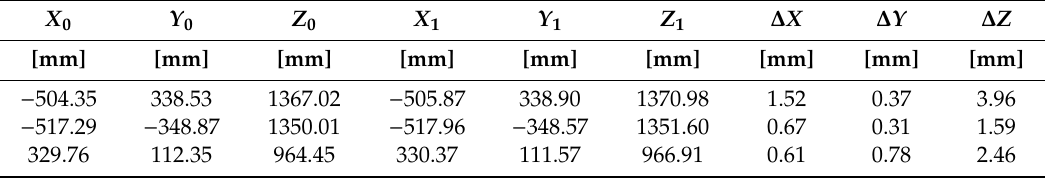
Table 3. Head-tracking reprojection error in calibration